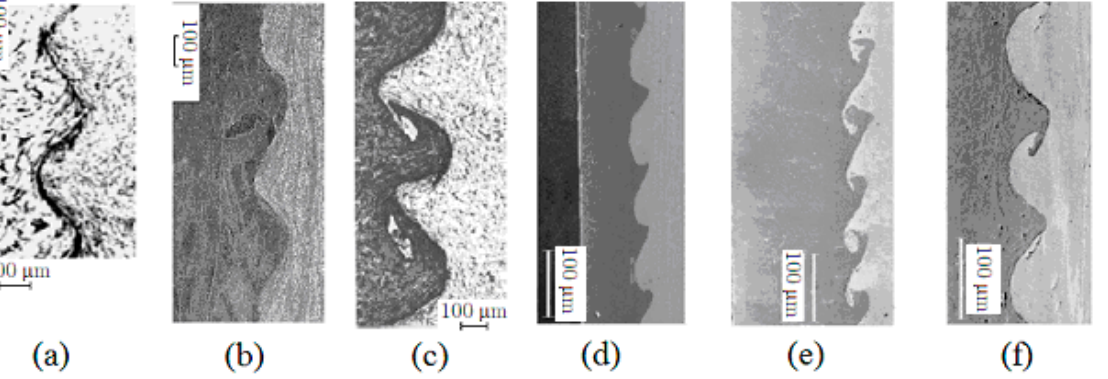
Figure 2. View of the weld at a microlevel: ( a ) symmetric wave; ( b , d ) asymmetric wave; ( c , e , f ) wave with a crest.